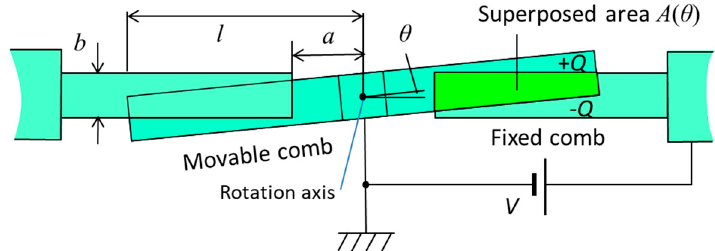
Figure 2. Schematic diagram of the cross-section of the electrostatic spring consisting of comb electrodes.